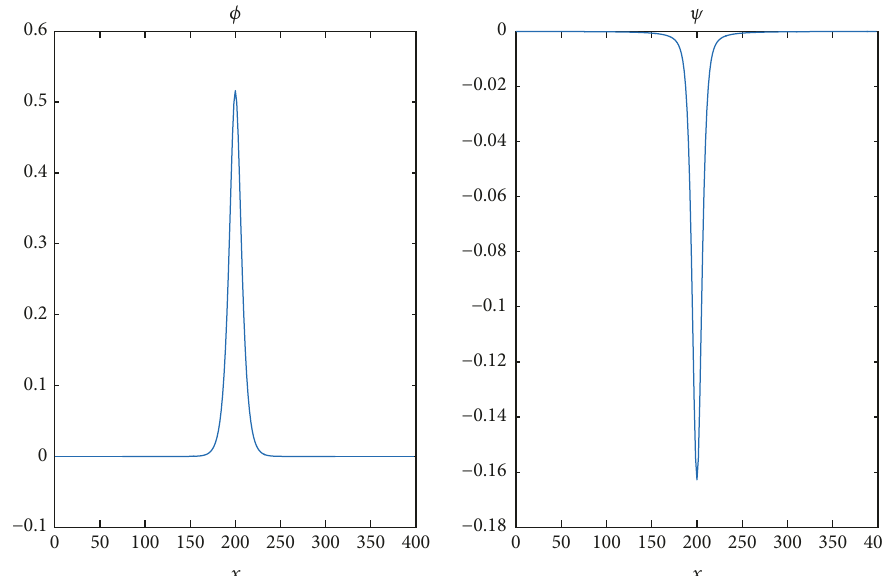
Figure 12: Approximations of the functions 𝜙,𝜓 in the solitary wave solution (39) with 5 Newton’s iterations. The model’s parameters are 𝛼 = 𝛽 = 0.4 , 𝛾 = −1 , 𝑤 = 0.1 , and wave speed 𝑐 = 0.5